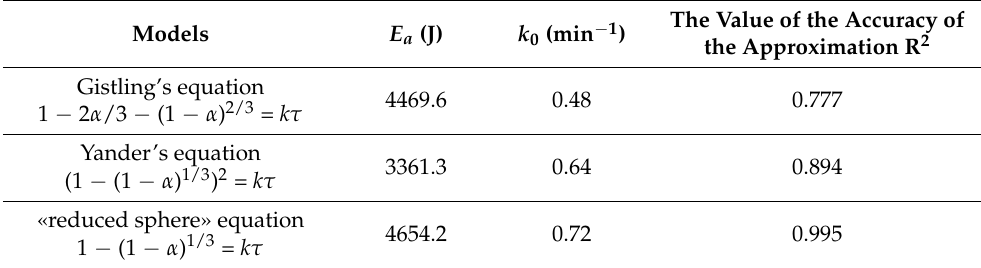
Table 1. Values of activation energy and pre-exponential coefficient of the fluorination of titanium dioxide with elemental fluorine, calculated by various models.